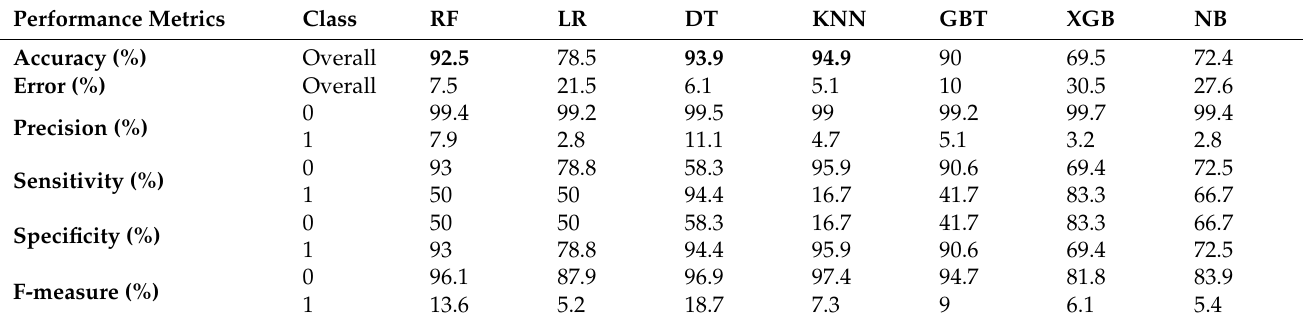
Table 3. ML Algorithms.